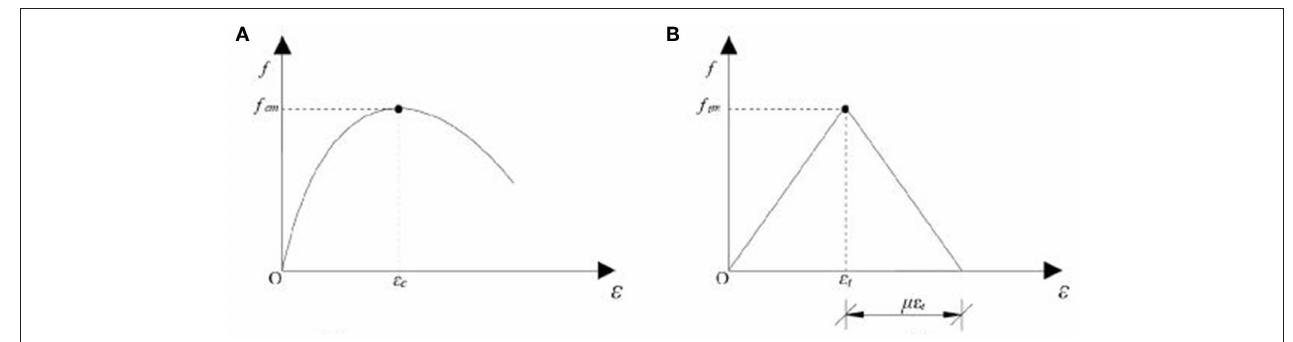
FIGURE 3 | Material constitutive laws: (A) compression and (B)